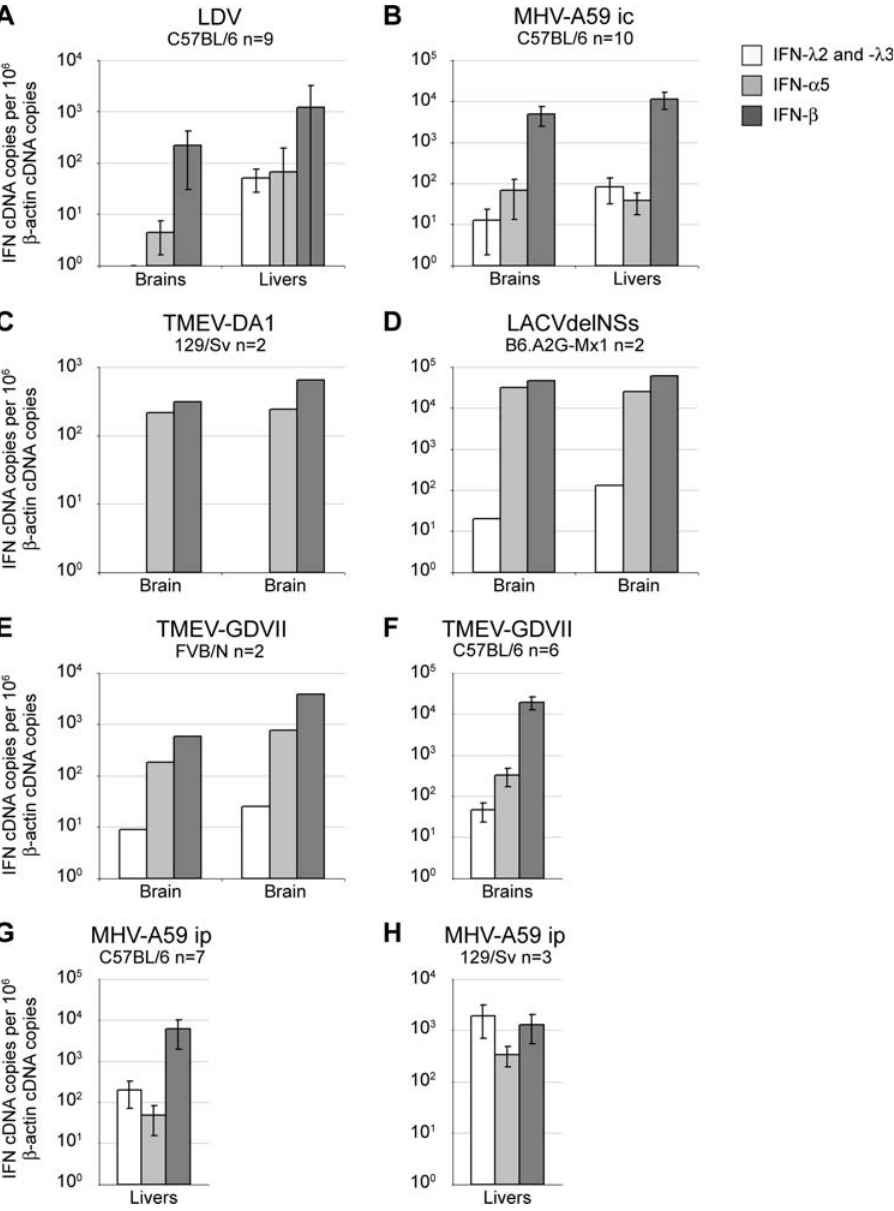
Figure 2. Quantification of IFN- l , IFN- a 5, and IFN- b transcripts in virus-infected brains and livers. Histograms show the number of IFN cDNA copies per 10 6 b -actin cDNA copies, determined by real-time PCR, after reverse transcription of RNA extracted from the brain and liver of mice infected with different RNA viruses, in different experimental settings (see Table 2). A, B, F, G, H: mean and standard deviation of groups of mice. C–E: data from individual mice. Background amplification in mock-infected mice (not shown) was less than 1 copy of IFN- b or IFN- l , and less than 10 copies of IFN- a 5 cDNA, per 10 6 copies of b -actin cDNA.